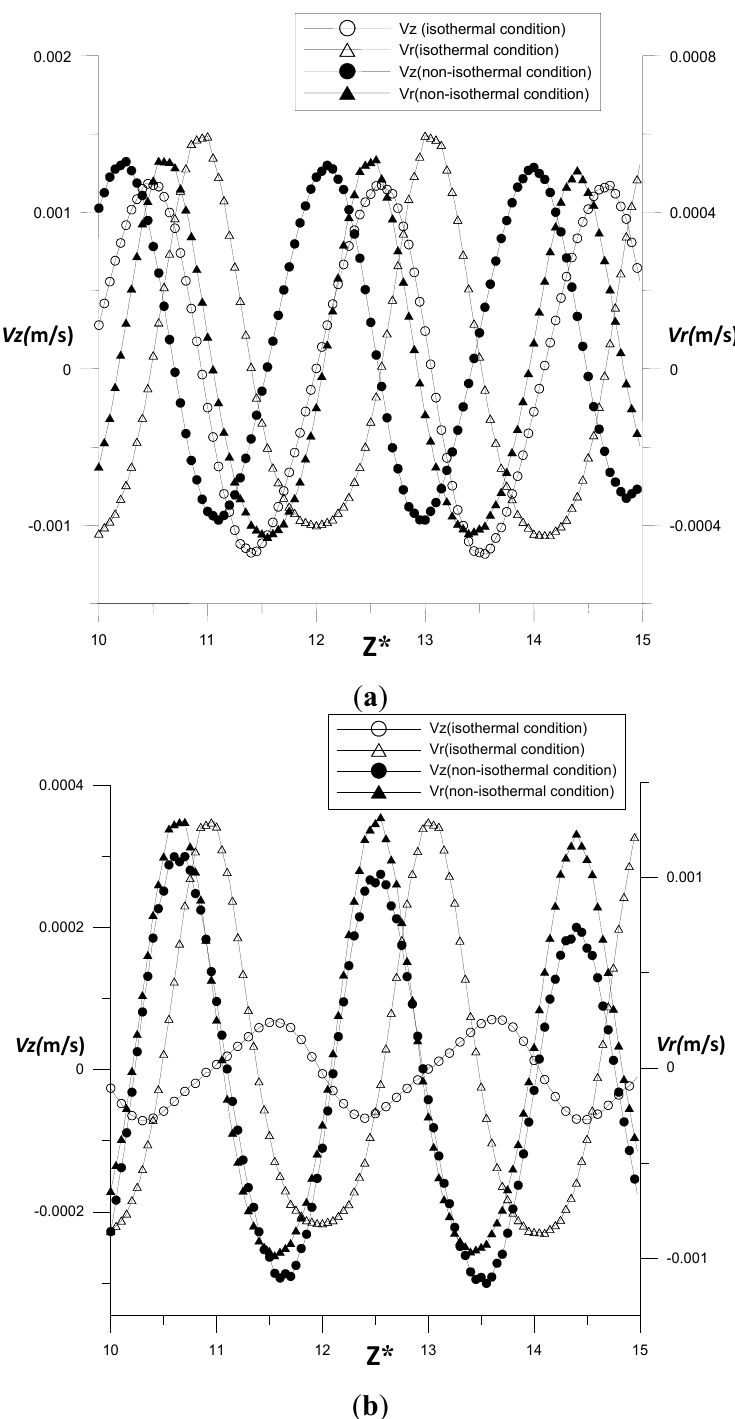
Figure 12. Radial and axial velocity along axial direction: ( a ) R * = 0.2; ( b ) R * =